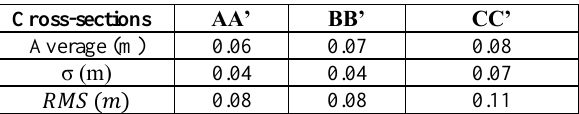
Table 3. Statistics on the differences between the AL and ML point clouds for each cross-section.